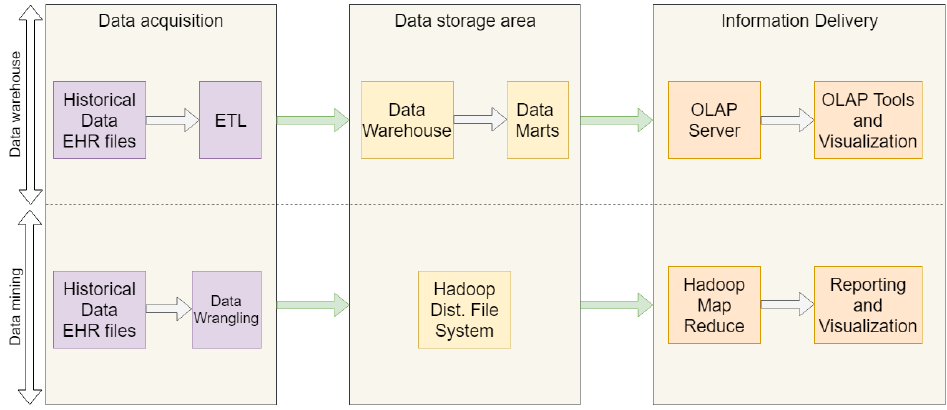
Figure 1. Data warehousing, OLAP and big data approaches (adapted from